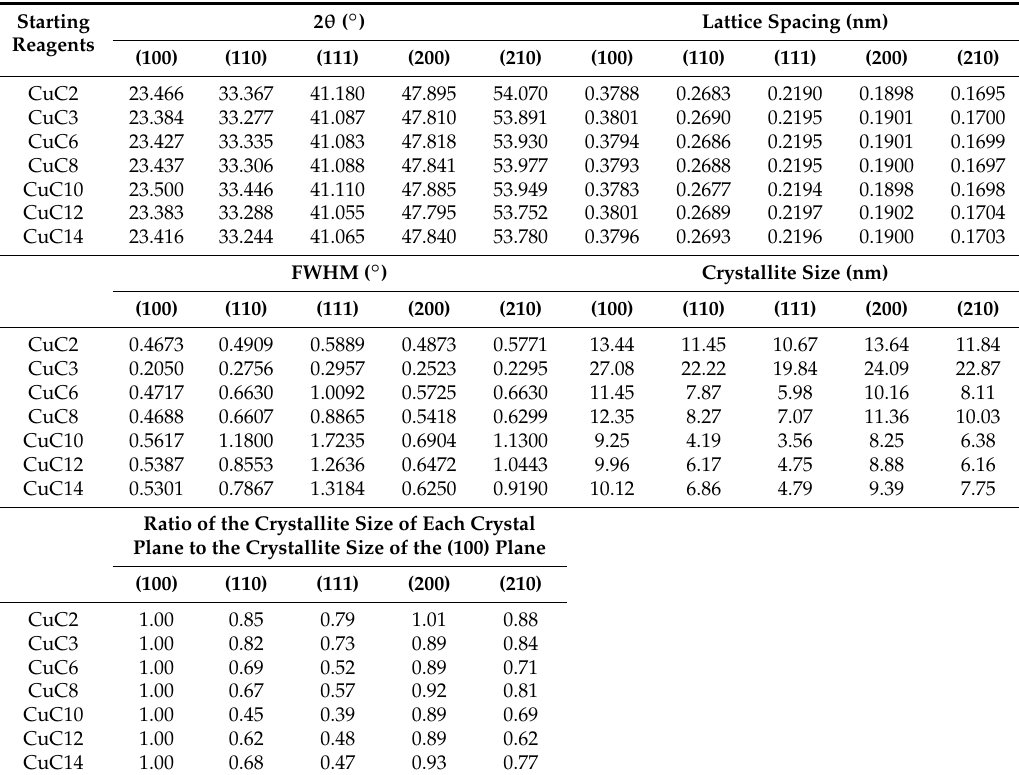
Table 2. Estimated values from peak fitting of XRD